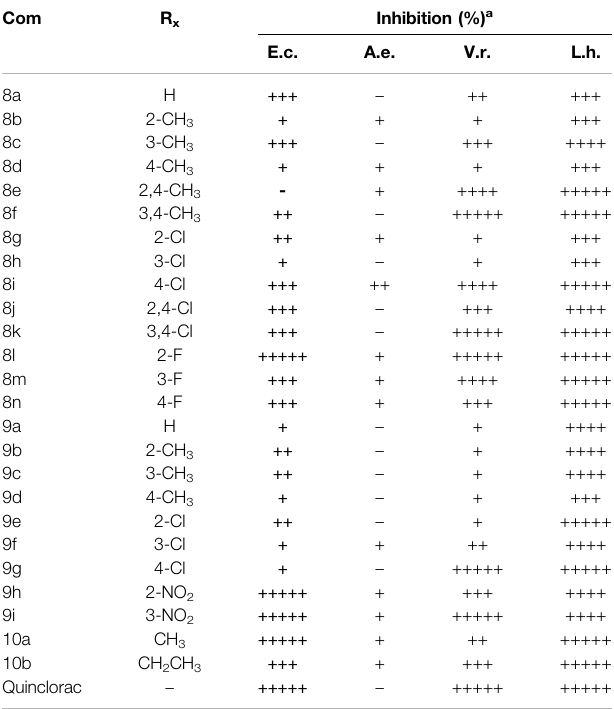
TABLE 1 | Postemergence herbicidal inhibition activity of compounds 8a-n, 9a-I, and 10a-b at a dosage of 375 g a.i./ha. Com R x Inhibition (%) a